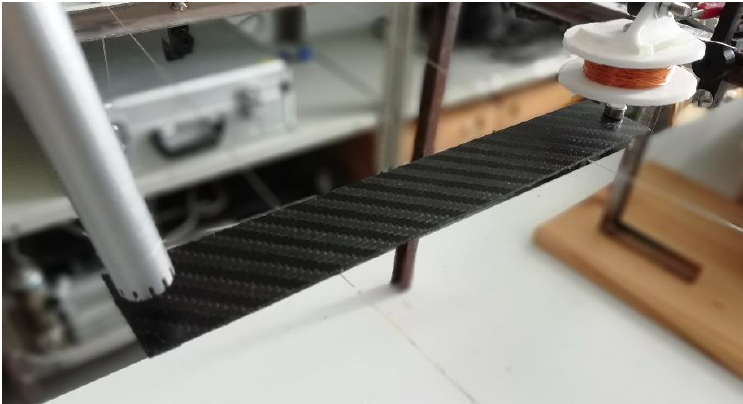
Figure 7. Experimental test for the modal analysis of prepreg CFRE plates.